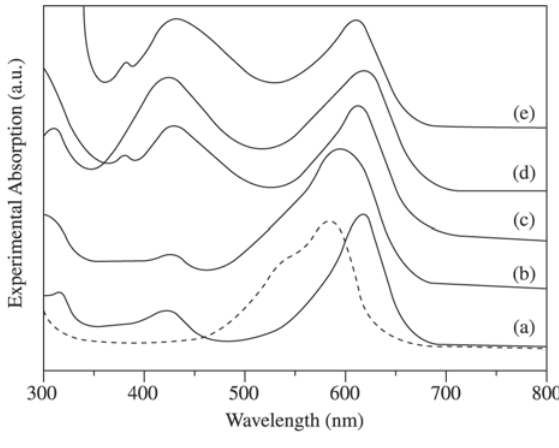
Figure 2. Absorption spectra. (a) MG (solid line) and CV (dashed line) aqueous solutions; (b) MG-CV aqueous solution; (c) MG in acidic medium; (d) CV in acidic medium; (e) supernatant liquid expelled from the gel after centrifugation (synerisis